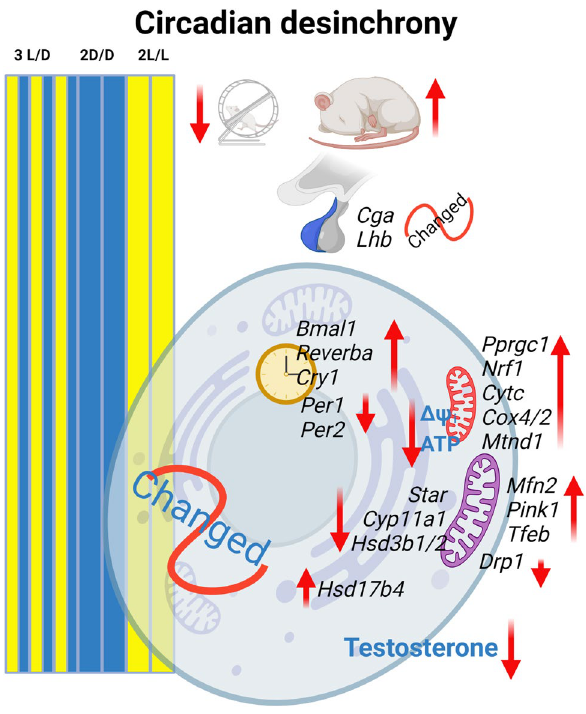
Figure 6. The cost of the circadian desynchrony on the Leydig cell function. The figure represents processes and genes affected by CD. The figure was created with